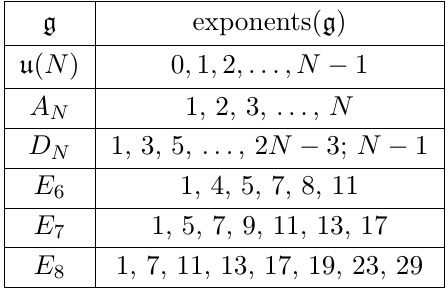
Table 2 . Exponents of the Lie algebra g